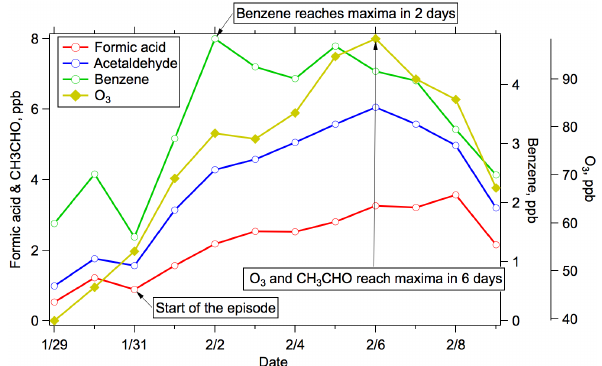
Figure 2. Buildup patterns of formic acid, acetaldehyde, benzene and ozone in 29 January–9 February in UBWOS 2013. Daily aver- ages of various species are